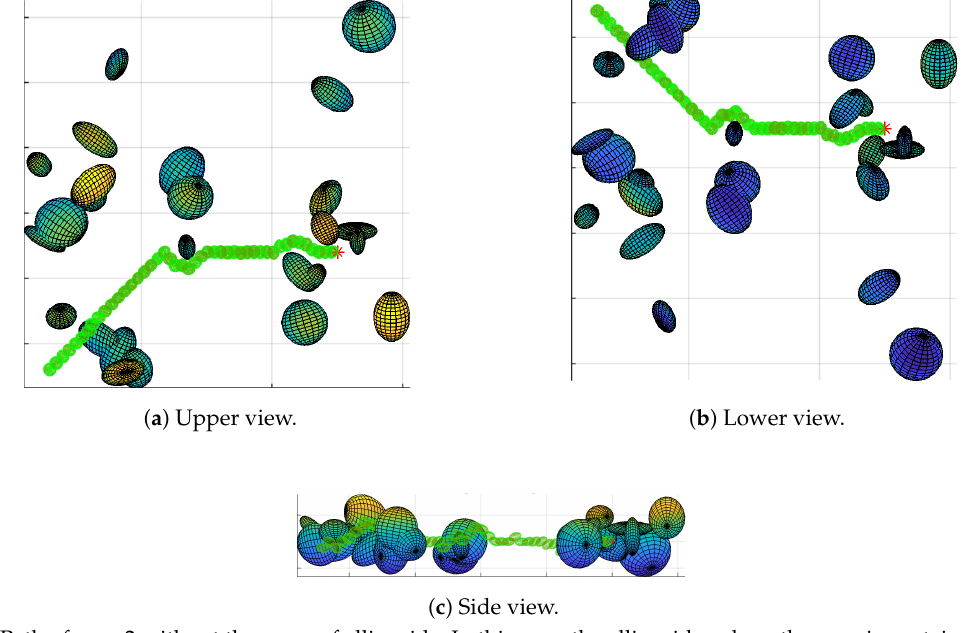
( c ) Side view. Figure 10. Path of map 2 without the room of ellipsoids. In this case, the ellipsoids, where the map is contained, have been removed. As can be seen, now the UAV can easily find a path above and beside the